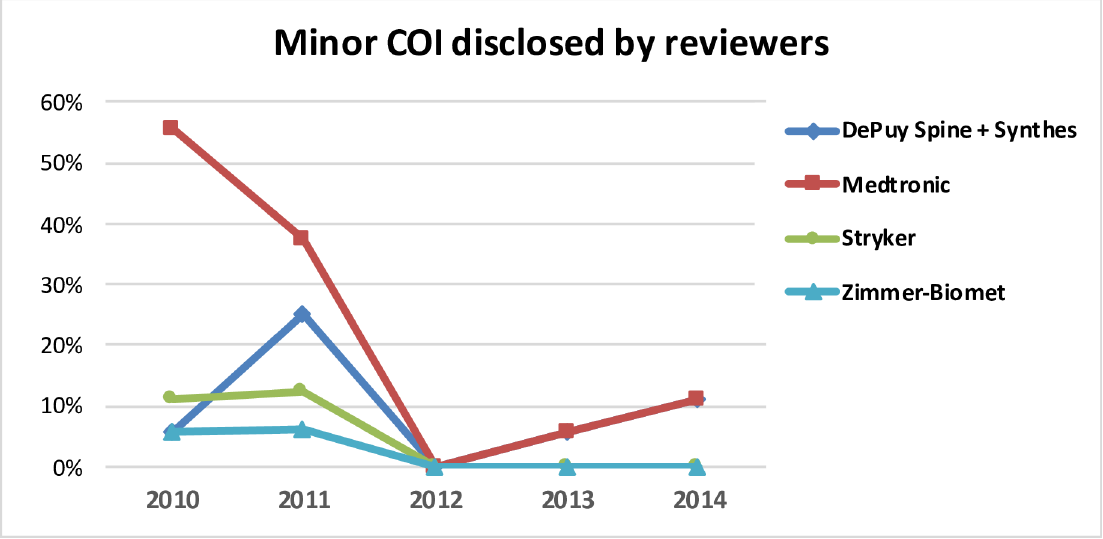
Fig 8. Distribution of minor COIs disclosed by the reviewers and associated to four of the five leading companies in relation to the total number of disclosed minor